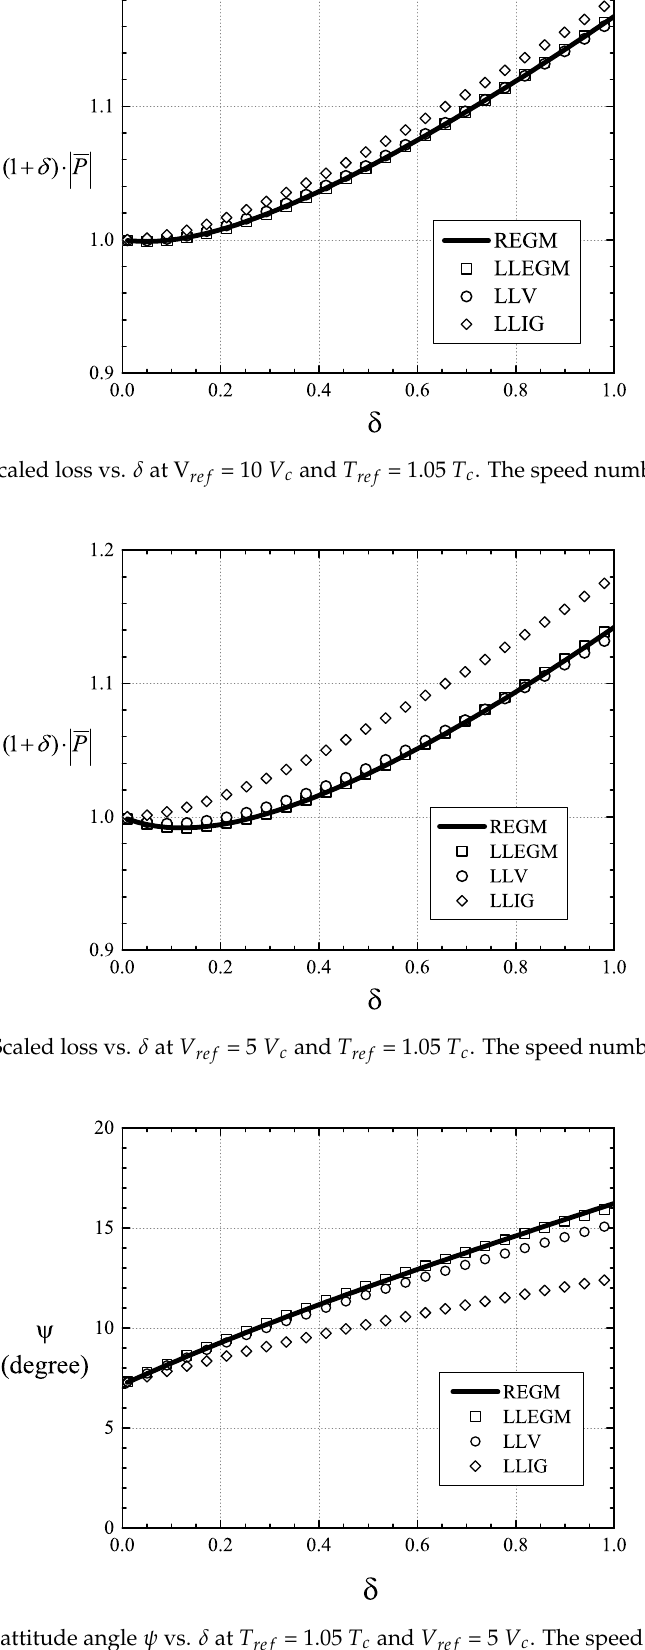
Figure 13. Scaled attitude angle ψ vs. δ at T ref = 1.05 T c and V ref = 5 V c . The speed number Λ =